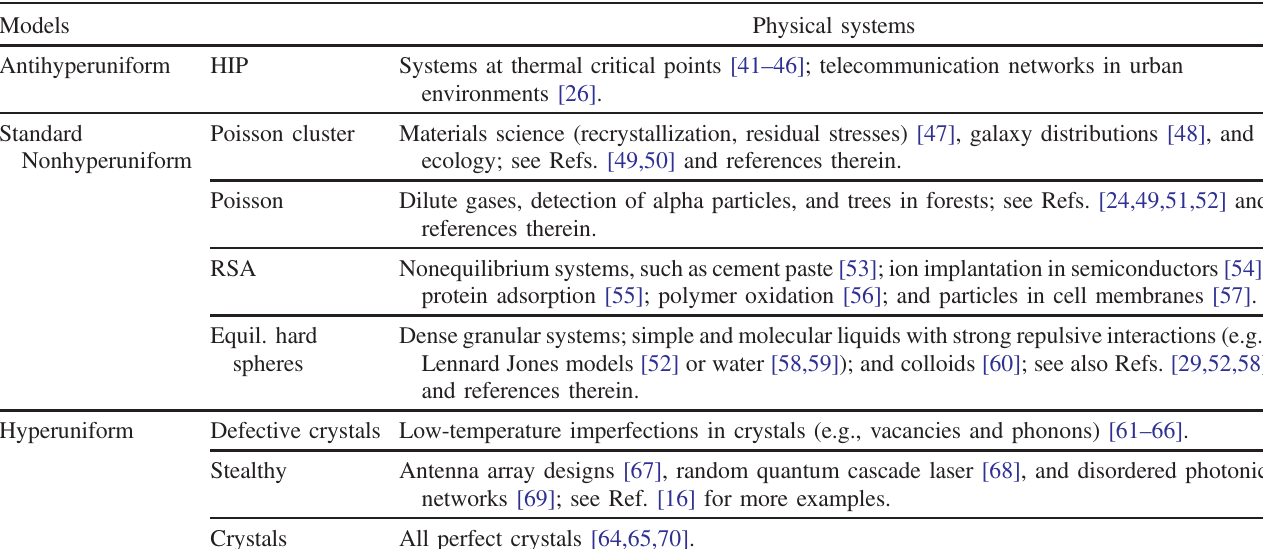
TABLE II. Other physical systems that are expected to display the salient fluctuation phenomena exhibited by the various models considered in this